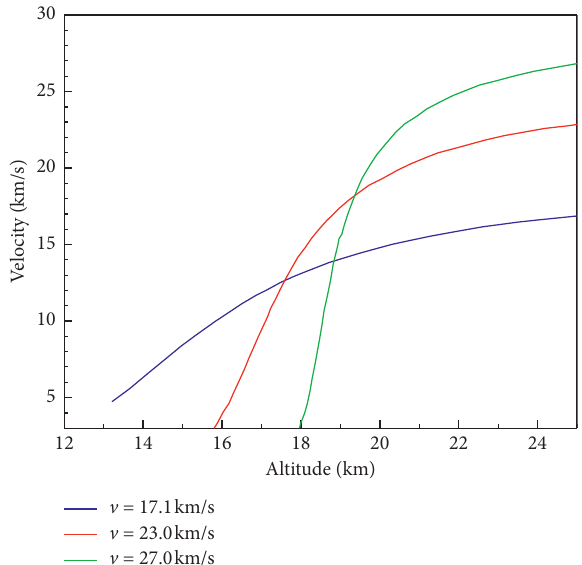
Figure 8: Simulation of the Chelyabinsk superbolide with different initial velocities ( v � 17.1, 23, and